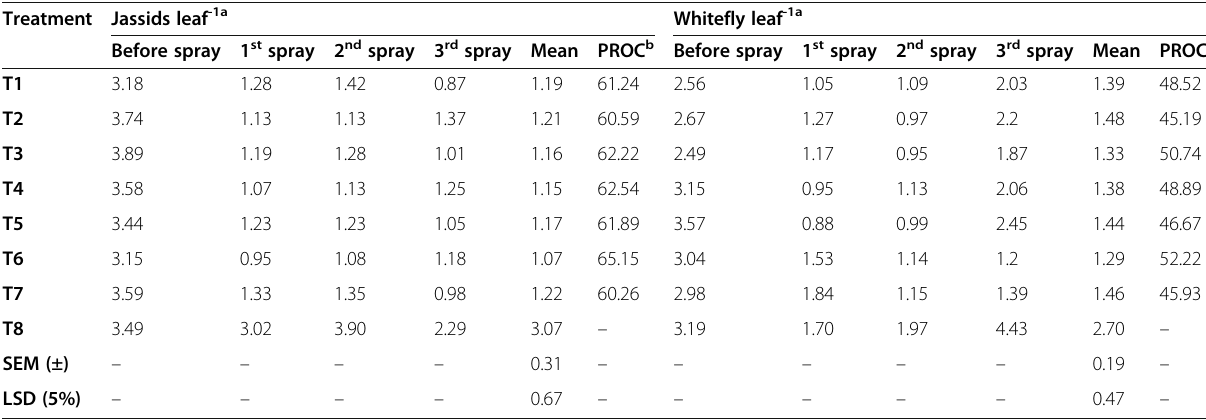
Table 1 Effect of different entomopathogenic fungi and neem oil alone and their 1:1 combination against major sucking pests of okra during 2018 Treatment Jassids leaf -1a Whitefly leaf -1a